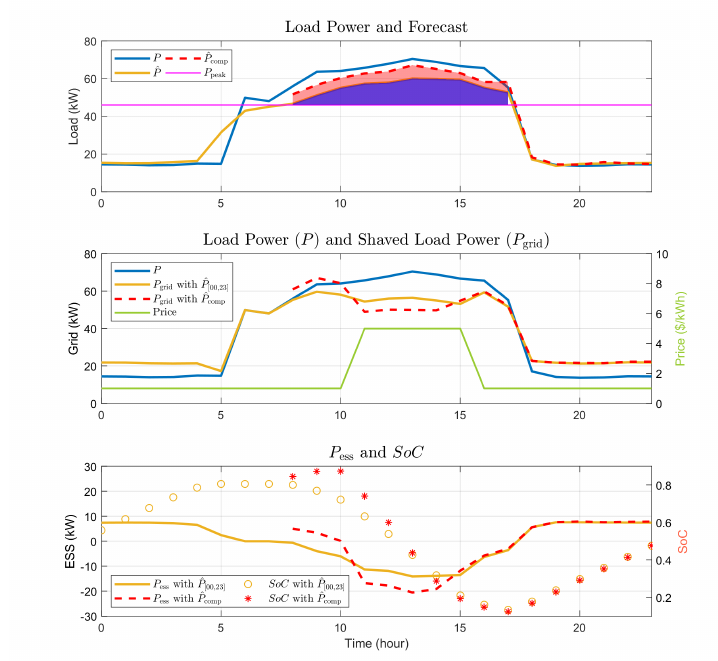
Figure 20. Result for Case 1. Significant peak shaving and large charging and discharging.